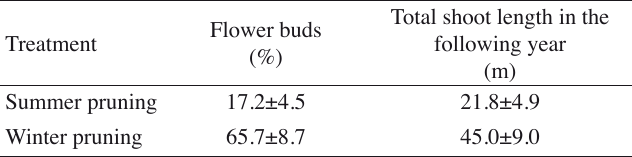
Table 3 - Effect of summer pruning on flower bud formation and total shoot length of peach trees in the following year